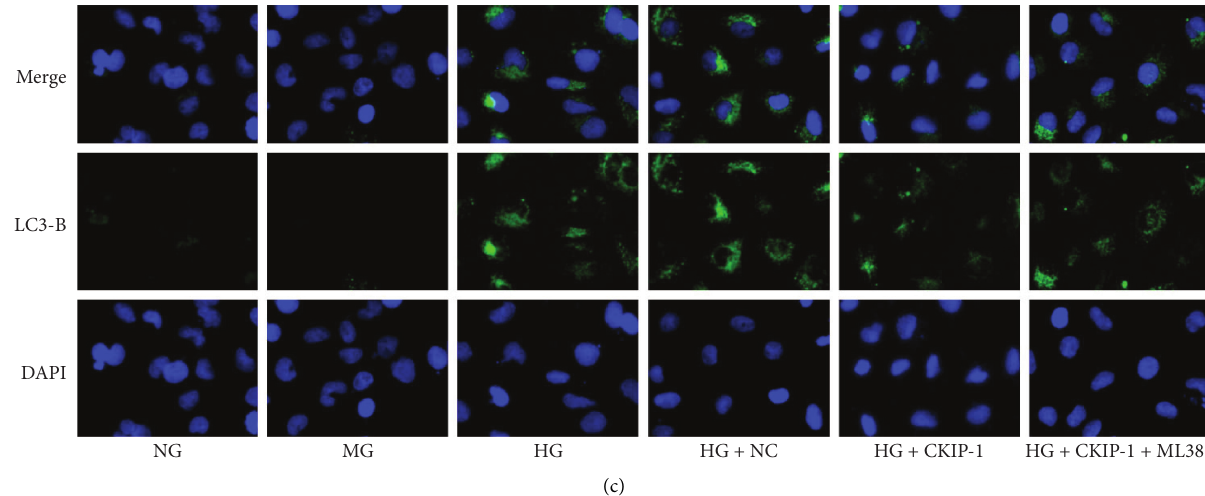
Figure 4: CKIP-1 inhibits high glucose-induced autophagy. (a) The LC3 and Beclin-1 expression was estimated by Western blots. (b) The protein expression of p62. (c) Immunofluorescence of LC3-II in ARPE-19 cells with different treatments. ∗∗∗ p < 0.001 vs. NG. # p < 0.05 and ### p < 0.001 vs. HG. Δ p < 0.05 and ΔΔΔ p < 0.001 vs. HG +NC. $ p < 0.05 and $$$ p < 0.001 vs. HG +CKIP-1. NG, normal glucose (5.5mM); MG, mannitol (20 mM); HG, high glucose (25mM); NC, pcDNA3.1 vector negative control; CKIP-1, pcDNA3.1-CKIP-1; ML385 (5 μ M), the Nrf2